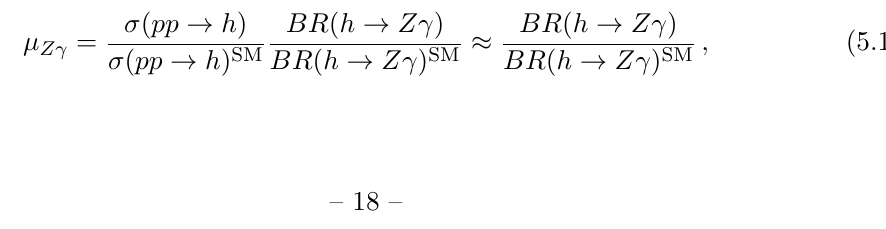
(cid:0) m = ( (cid:0) 50 ; 50) H (cid:6)(cid:6) H (cid:6)